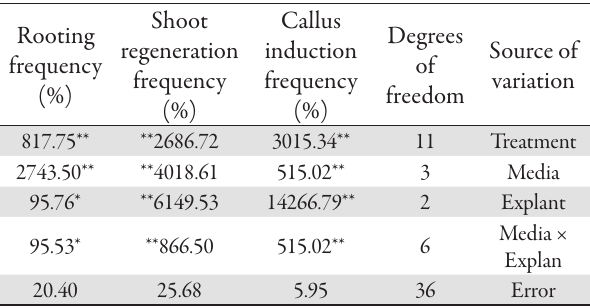
Tab. 1. Analysis of variance for studied traits of Foeniculum vulgare on MS medium Rooting